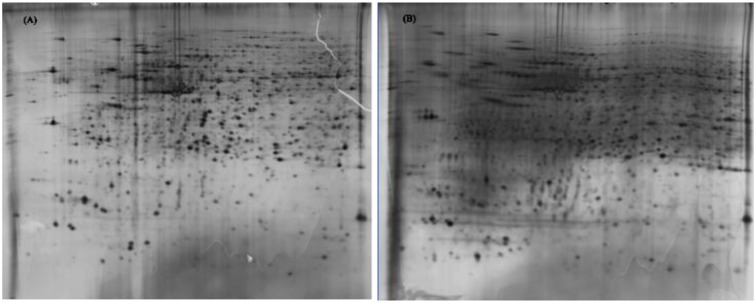
2-DE gel images of AIV-infected and control groups of A549 cells at 72 hpi. (A): 2-DE gel of the AIV-infected group. (B): 2-DE gel of the control group.